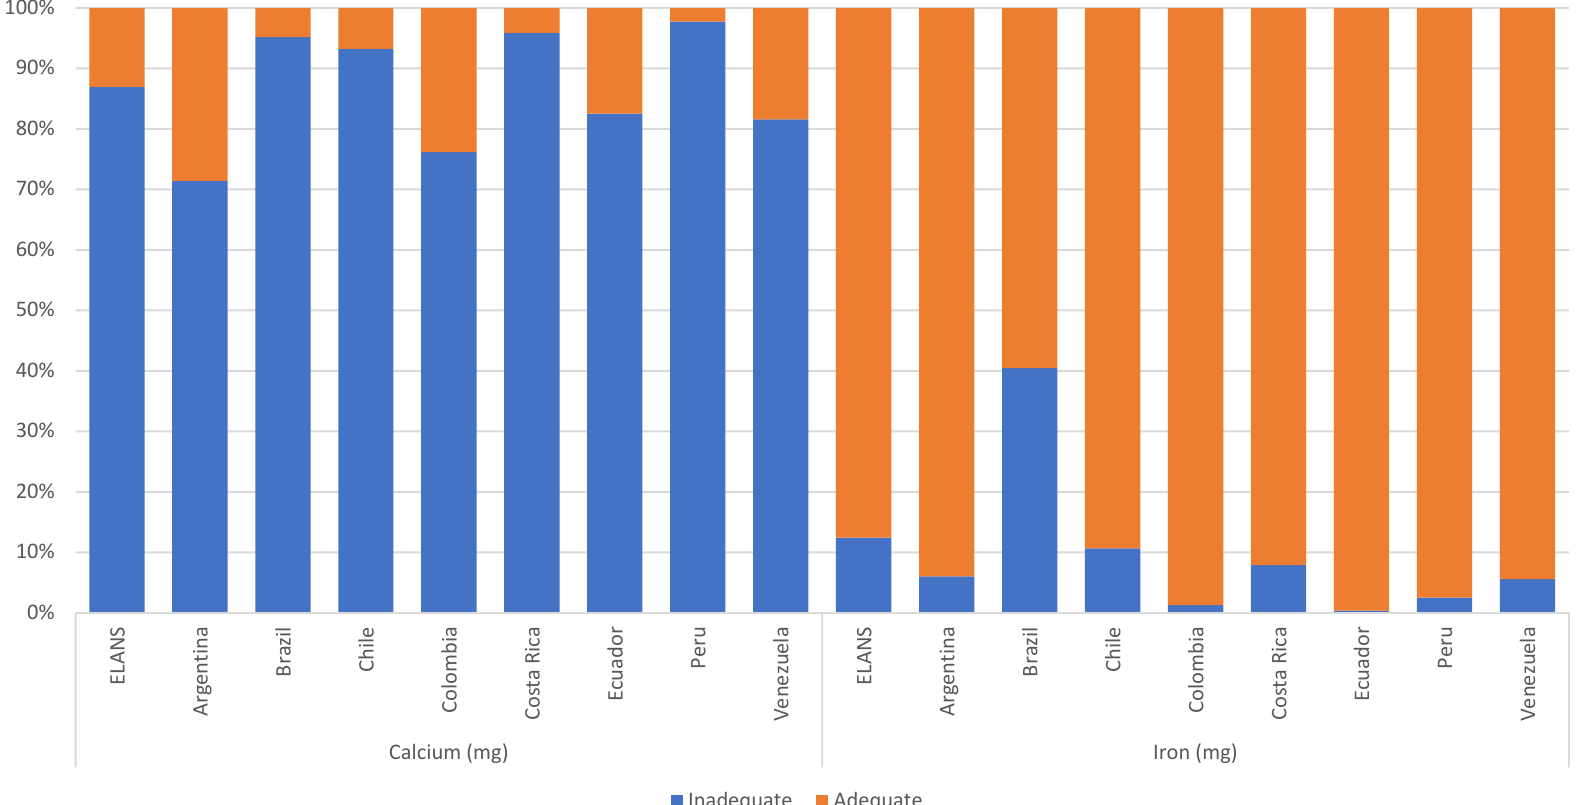
Figure 2. Percentages of individuals by adequacy level of calcium and iron intake among Latin American countries; Latin American Health and Nutrition Study (ELANS), 2015.